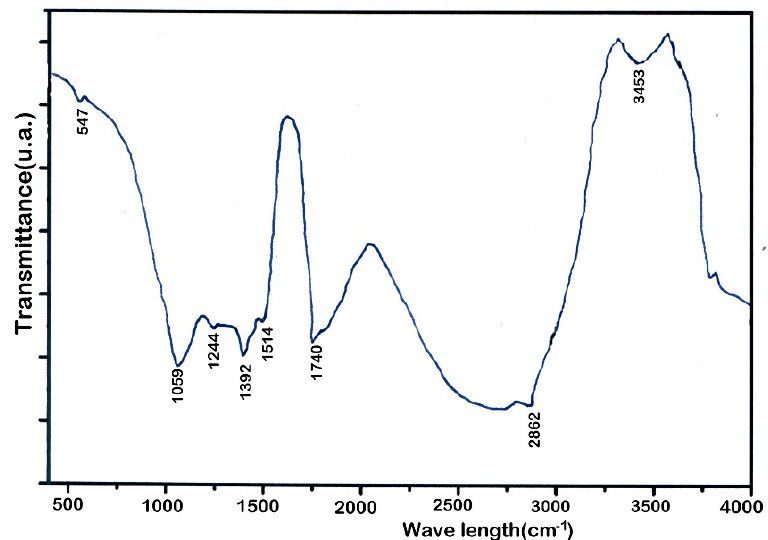
Figure 4. Functional groups of RRB determined by FTIR analysis. Table 2. Surface area and total pore volume of the nanocomposites prepared and used as catalysts.